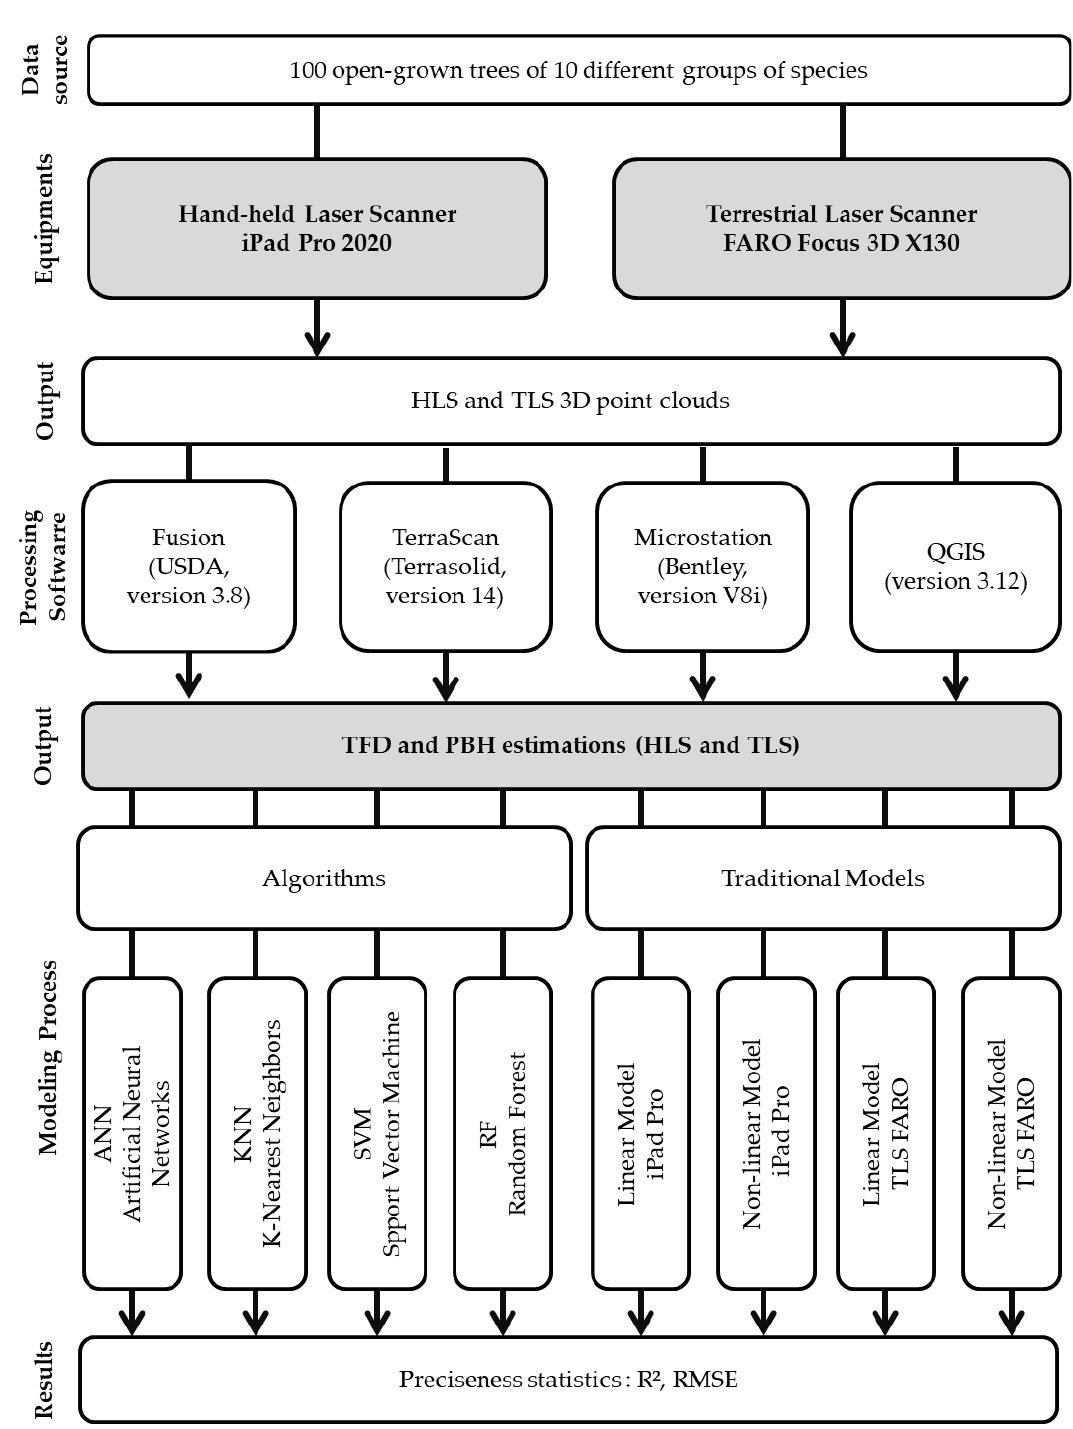
Figure 4. Flowchart describing the sequence of research steps.